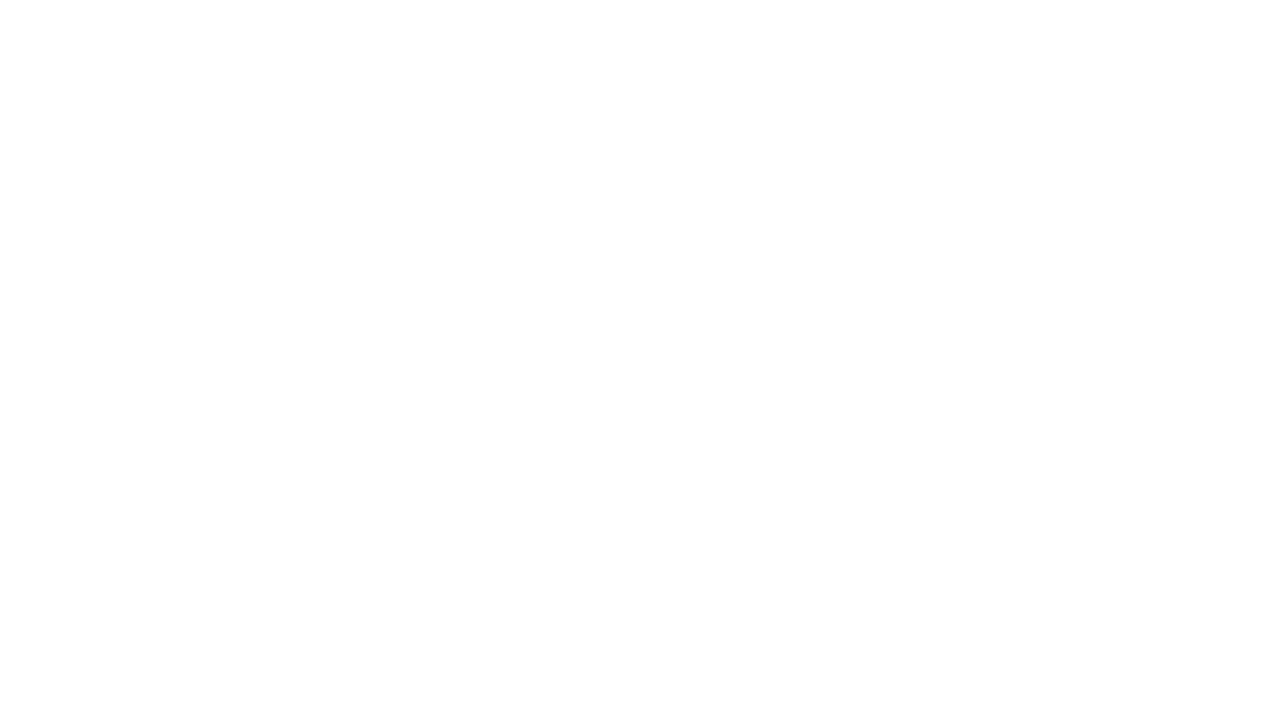
FIGUREA7 | Neighbor-joining phylogenetic tree of Chloroflexi 16S rRNA sequences from all clone libraries . (A) Sub-branch of tree corresponding to Roseiflexus spp. (B) Sub-branch of tree corresponding to FAPs related to Chloroflexus spp. and other organisms capable of producing